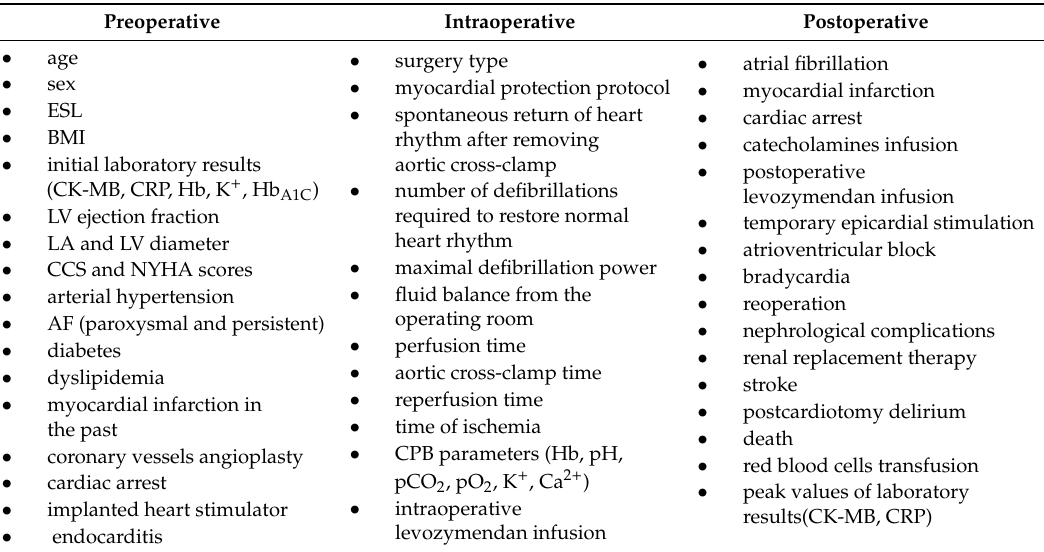
Table 2. Analyzed perioperative factors.